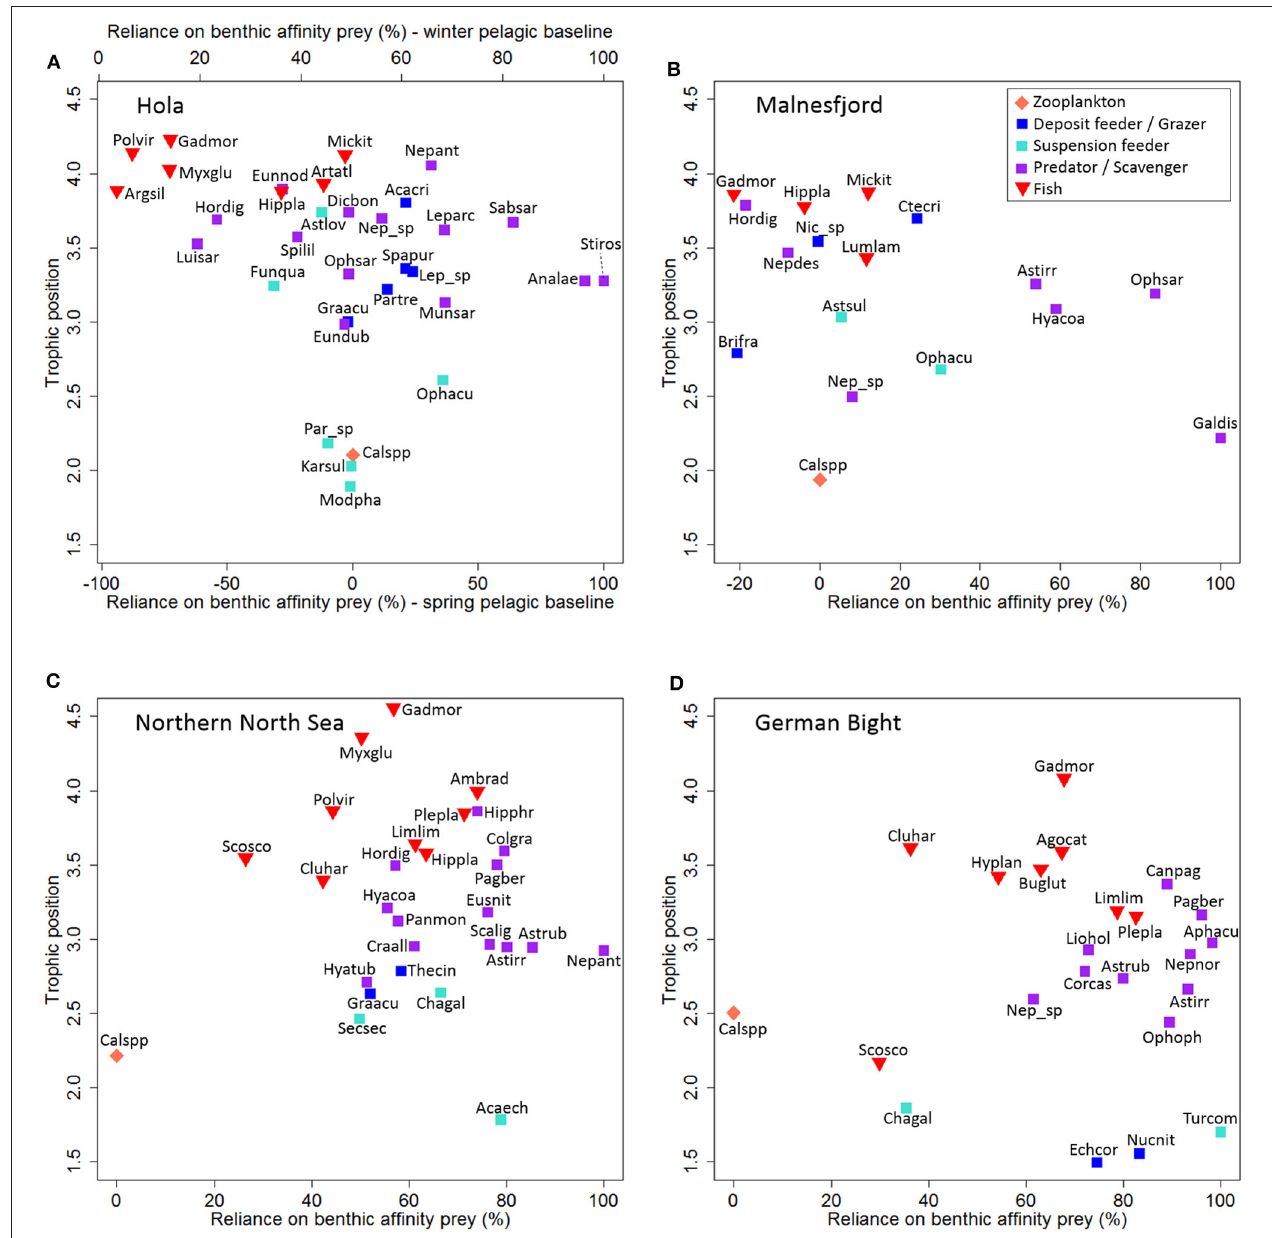
FIGURE 3 | Reliance on benthic affinity prey and trophic position for all faunal taxa at the study locations Hola (A) , Malnesfjord (B) , northern North Sea (C) , and the German Bight (D) . Labeling according to taxon code shown in Table 1 . A second x-axis (Top) for Hola shows the calculated reliance on benthic affinity prey using a winter pelagic